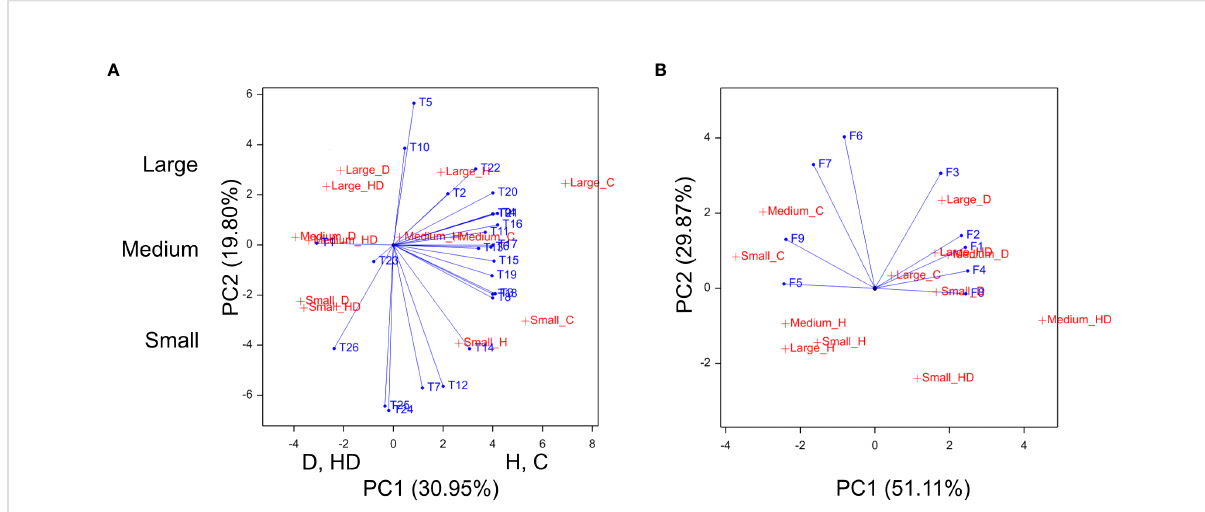
FIGURE 4 Biplots for phenotypic traits (A) , chlorophyll fl uorescence parameters at T2 (B) . In (A) , axis PC1 discriminates treatments C, D, H, and HD, axis PC2 — groups of genotypes classi fi ed according to the fl ag leaf size: large, medium, and small; T1 – T26, phenotypic traits and phenological stages, F1 – F9, chlorophyll fl uorescence